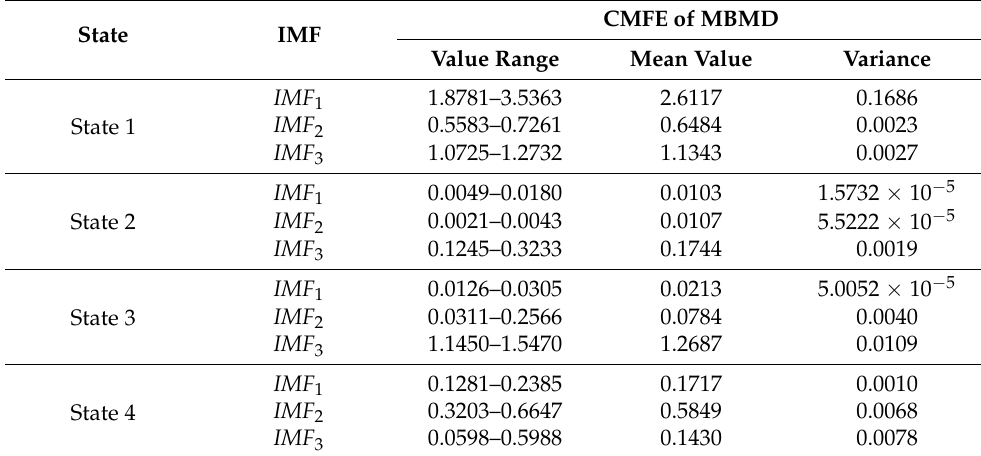
Table 4. CMFE evaluation parameters of MBMD in four